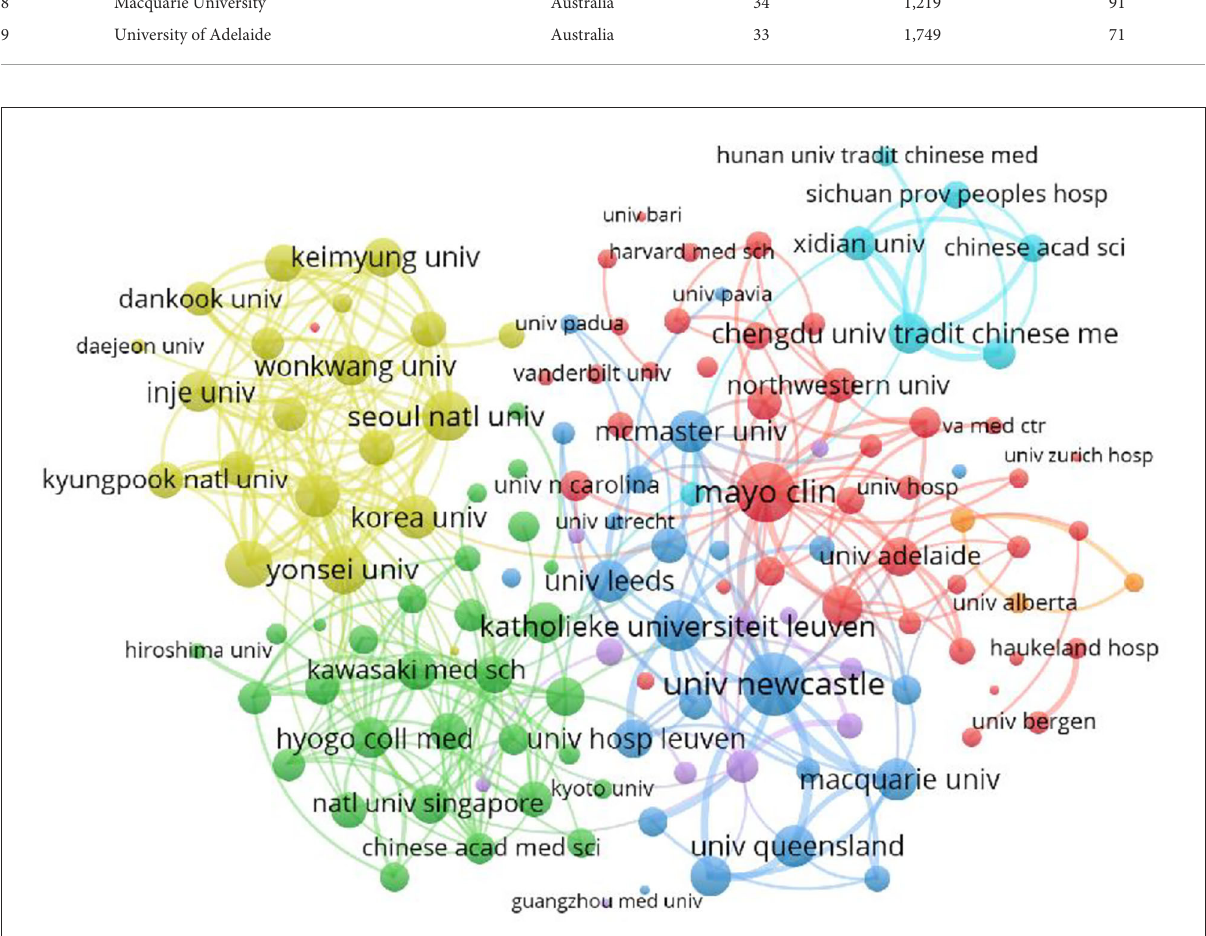
FIGURE4 Co-occurrence of organizations on FD. The size of circles was total link strength. The thickness of the lines indicates the strength of the relationship. The color means different cooperative networks.